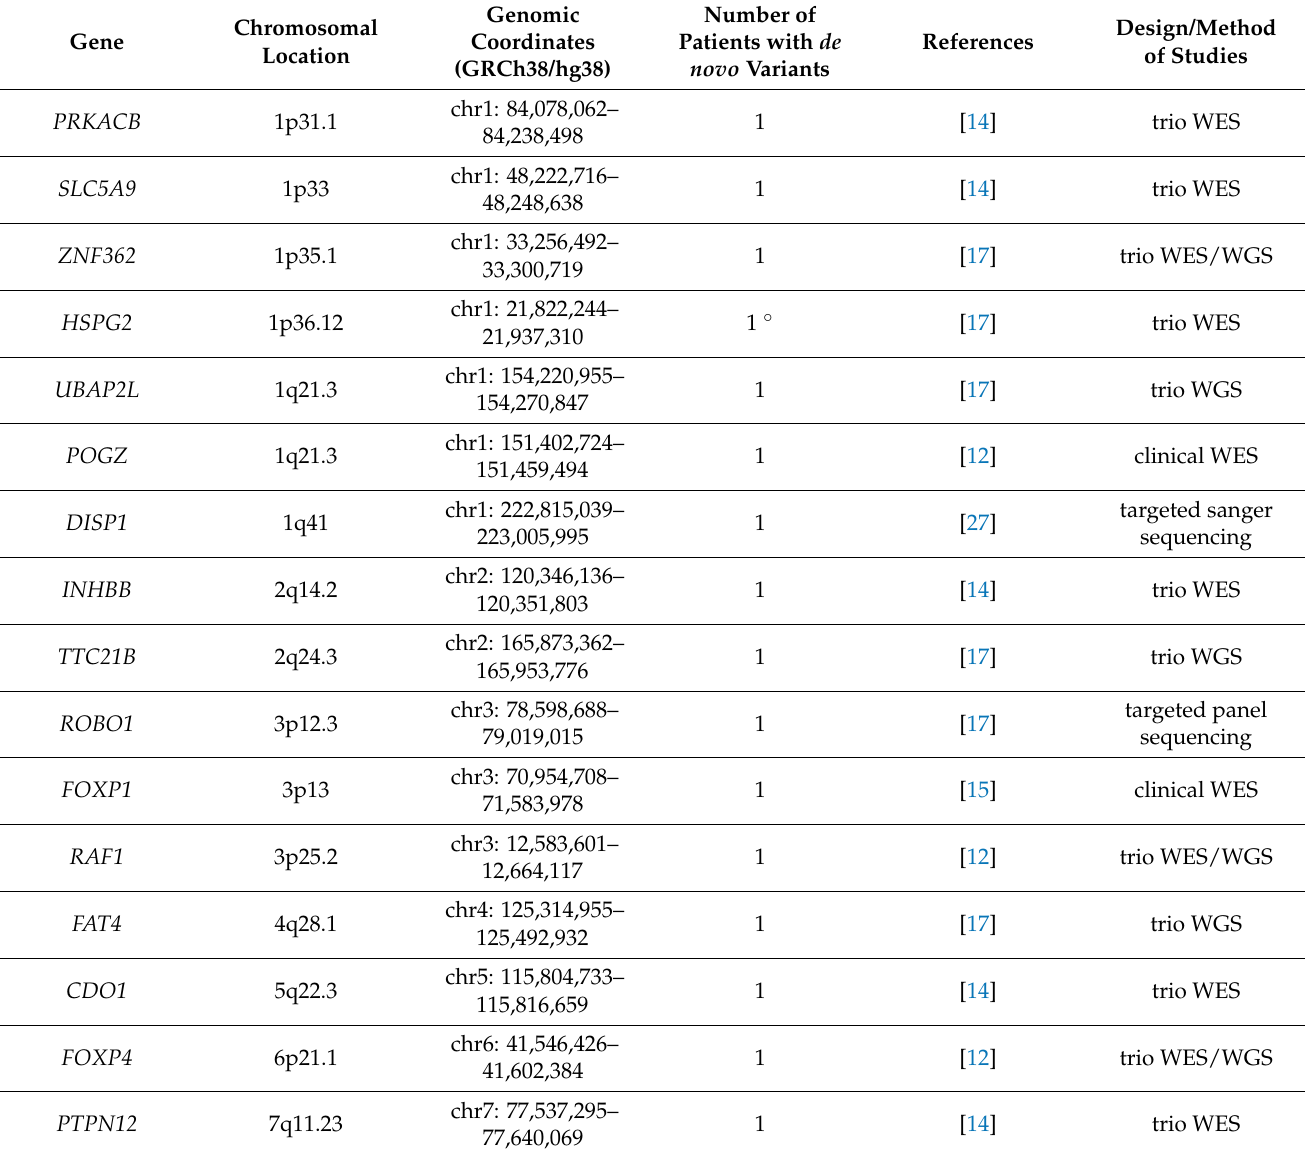
Table 2. Genes with de novo variants in non-isolated CDH